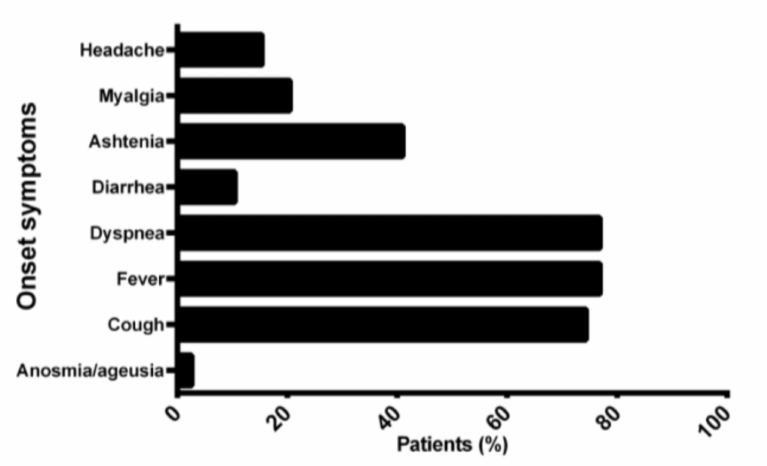
Figure 1. Most prevalent symptoms at COVID-19 pneumonia onset. Data are expressed as the percentage of patients.